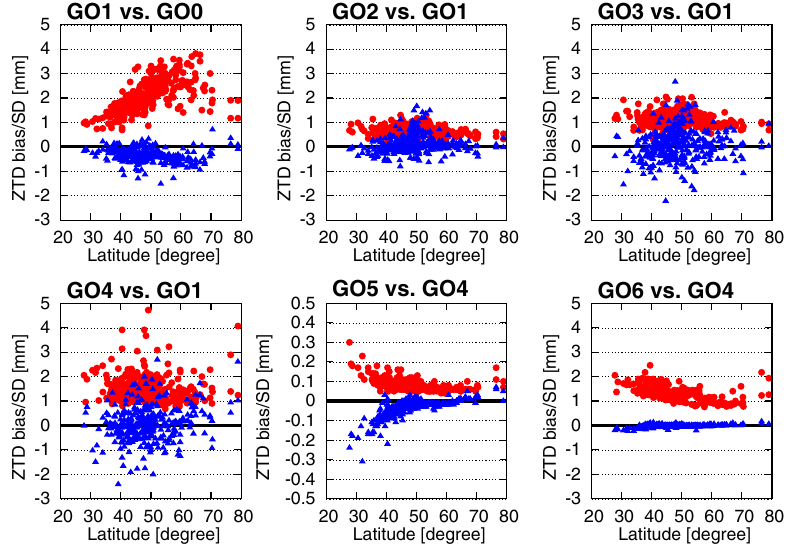
Figure 12. Dependence of ZTD biases (blue) and standard deviations (red) from inter-comparisons of the GOP second reprocessing solution variants on station latitude. Note the different y range for the GO5 vs. GO4 comparison.